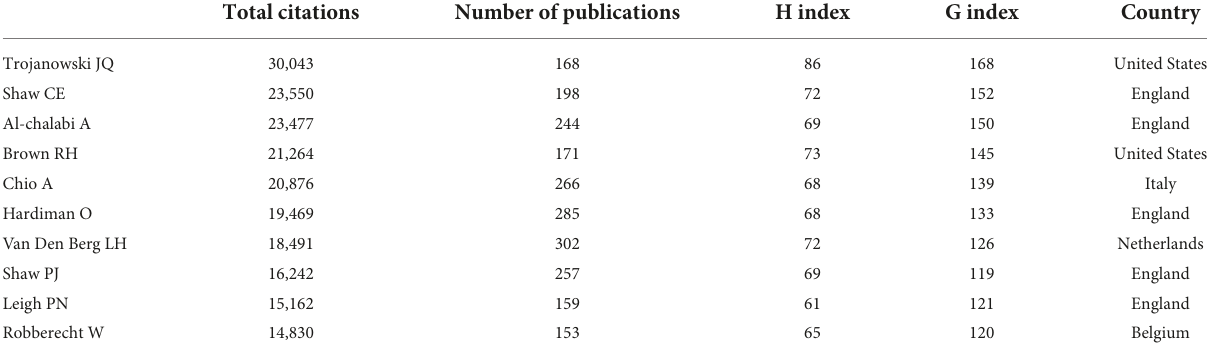
TABLE 3 Overview of top 10 most influential authors in ALS